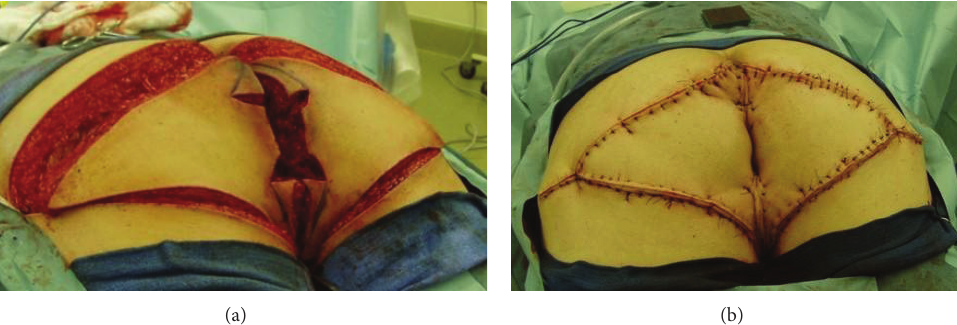
Figure 3: A V-to-Y gluteal fasciocutaneous flap reconstruction was performed.